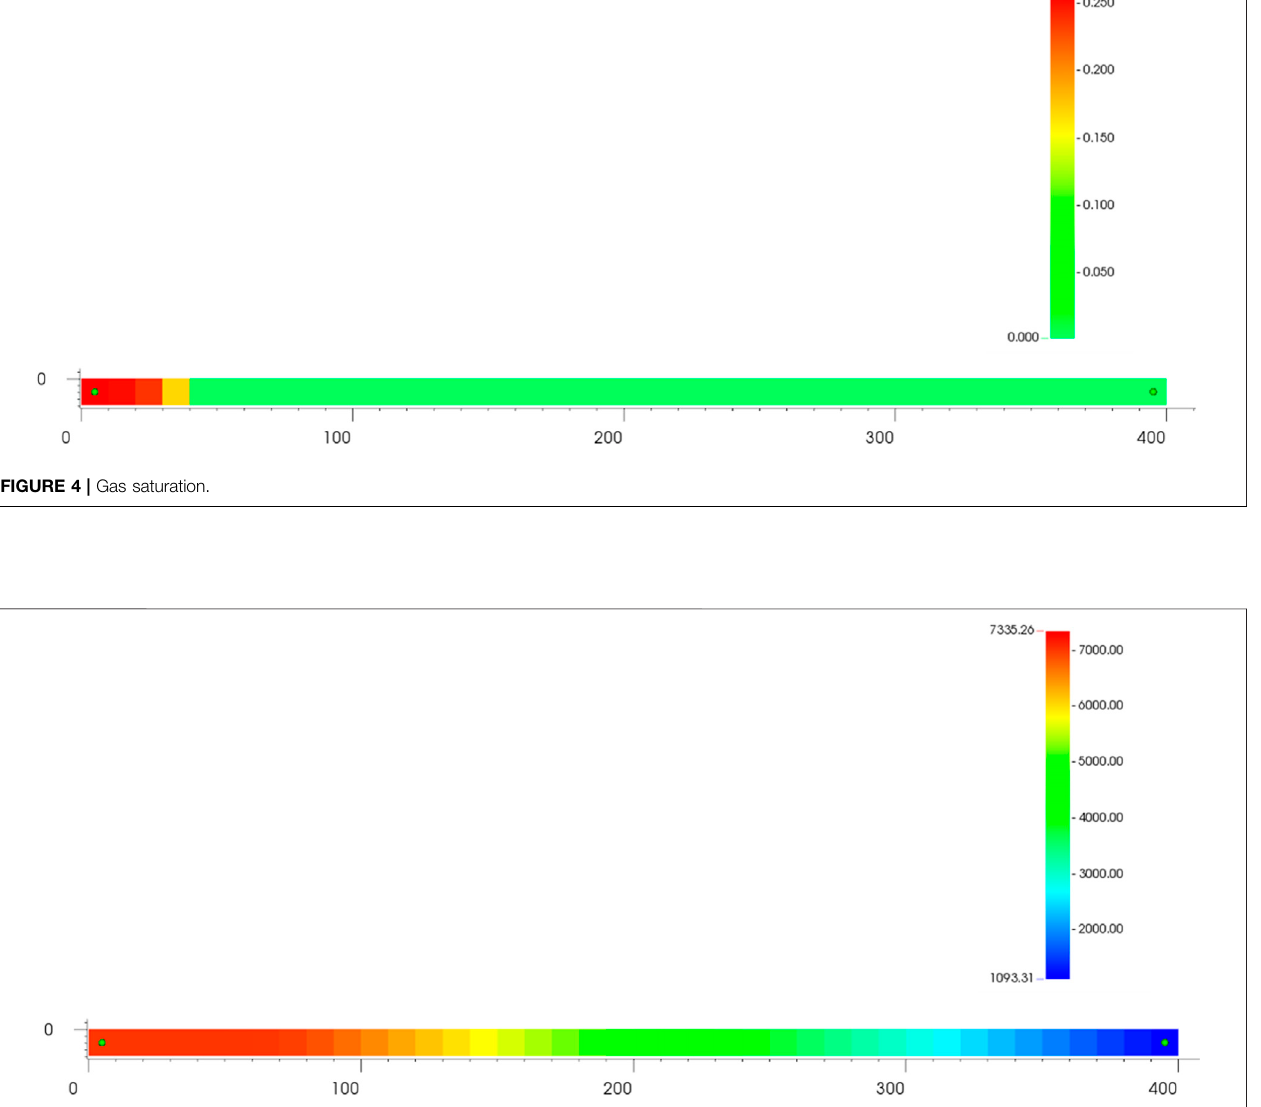
FIGURE 5 | Pressure